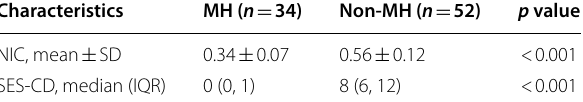
NIC Normalized iodine concentration, SES-CD Simple endoscopic score for CD